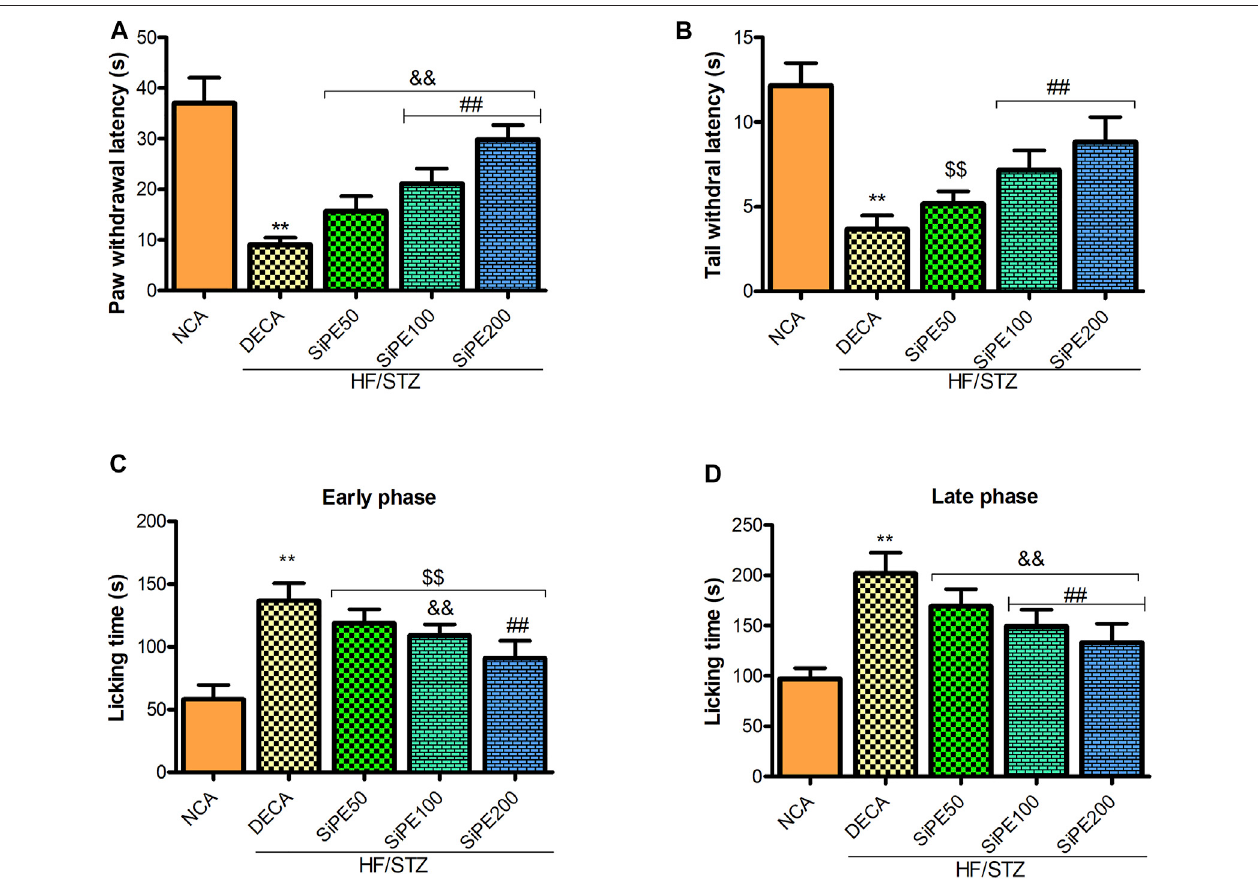
FIGURE5| EffectofSiPE treatment on thermaland chemicalhyperalgesiainHF/STZ-induceddiabeticencephalopathic rats.SiPE treatmentatdose of50, 100or 200 mg/kg signi fi cantly ameliorated (A) paw withdrawal latency, (B) tail withdrawal latency, (C) paw licking time (early phase) and (D) paw licking time (late phase) compared to DECA group. Data are presented as mean ± SD ( n (cid:2) 6) and one-way ANOVA test was applied. ** p < 0.001 indicates statistical signi fi cance compared to NCA group. ## p < 0.001, && p < 0.01 and $$ p < 0.05 indicate statistical signi fi cance compared to DECA group.